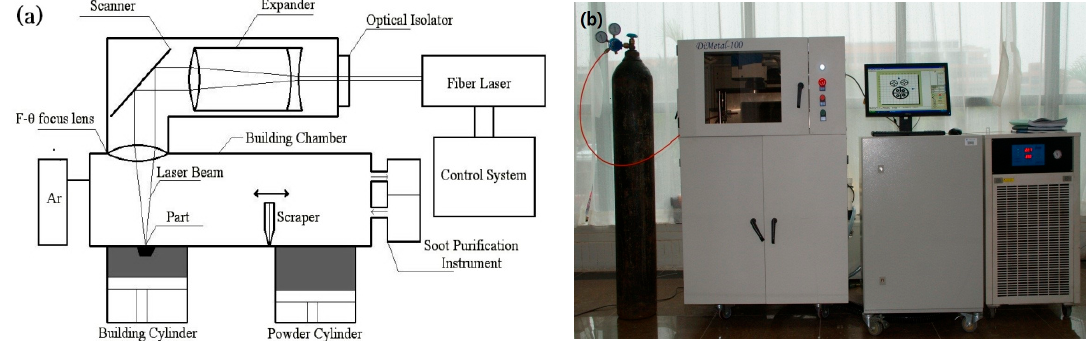
Figure 2. Principle of SLM manufacturing and the experimental DiMetal-100 equipment. ( a ) Principle of SLM manufacturing; and ( b ) DiMetal-100.